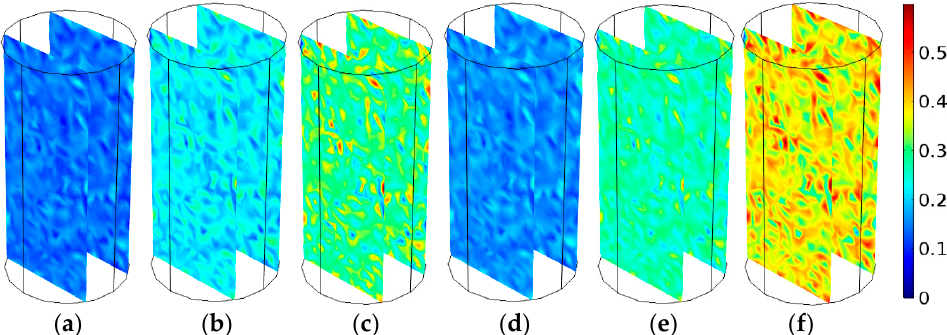
k = 2, T = 75 °C): ( a ) pH = 6, w